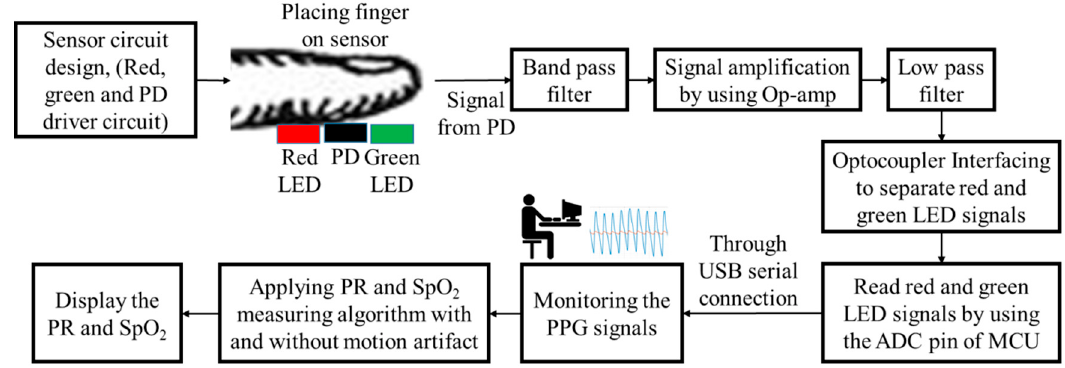
Figure 4. PO device development procedures. ADC, analog-to-digital converter; MCU, microcontroller unit. Table 1. List of the components to develop the pulse oximeter (PO) device. LED, light-emitting diode; PD, photodetector; MCU, microcontroller unit; TFT, thin-film-transistor. Serial